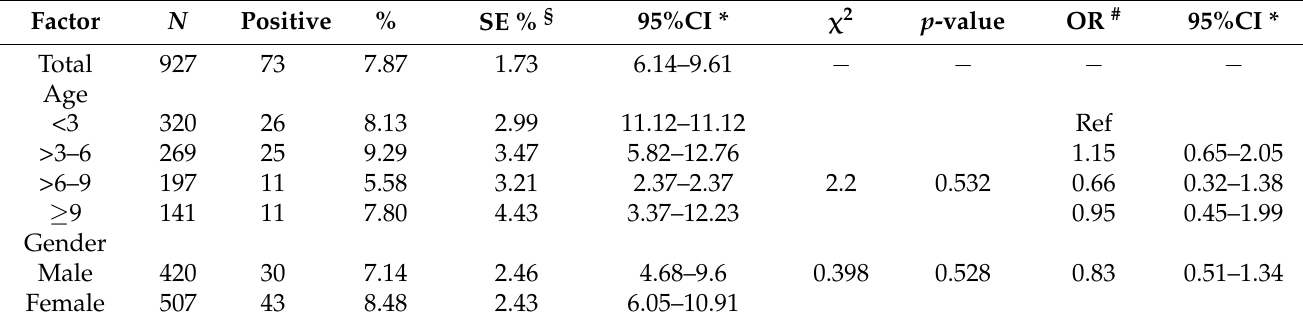
Table 5. Seroprevalence of infection with Anaplasma spp. and risk factor analysis by age and gender in stray dogs in the Campania Region in 2016–2019 as detected by qualitative dot-ELISA SNAP 4DX ® (IDEXX Laboratories).